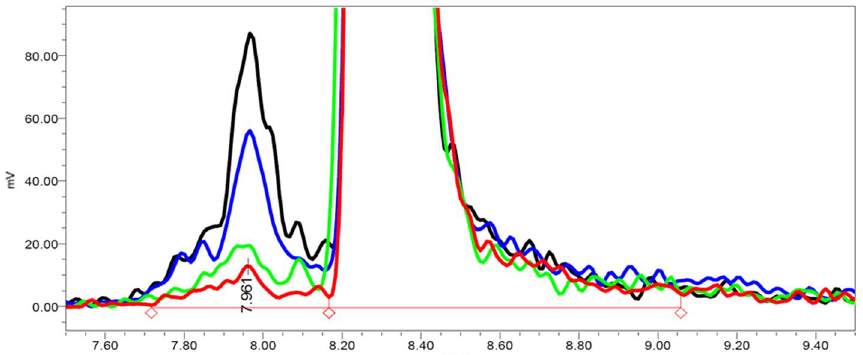
Fig. 2 Increased radiolysis formation over time, as measured by HPLC analysis (t (blue) and t 48 h =